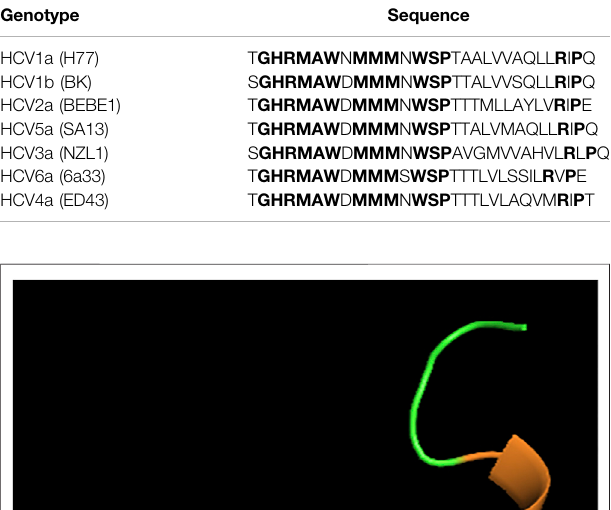
TABLE 5 | Sequence alignment of the region (265 – 298) across various HCV genotypes (Li et al., 2009). In bold are represented the highly conserved residues. In green, amino acids modi fi ed by mutagenesis. Underlined conserved motives GDLC and VFLVG.